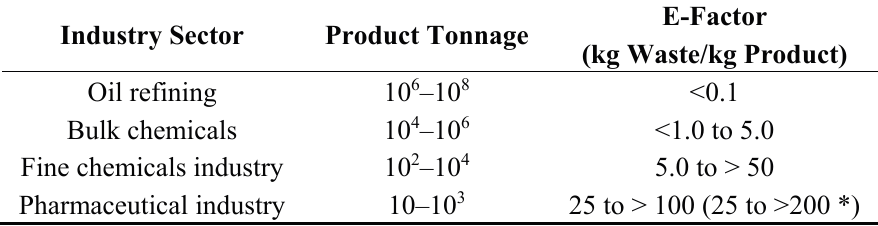
Table 1. The numerical values of E-Factors in different chemical industry sectors